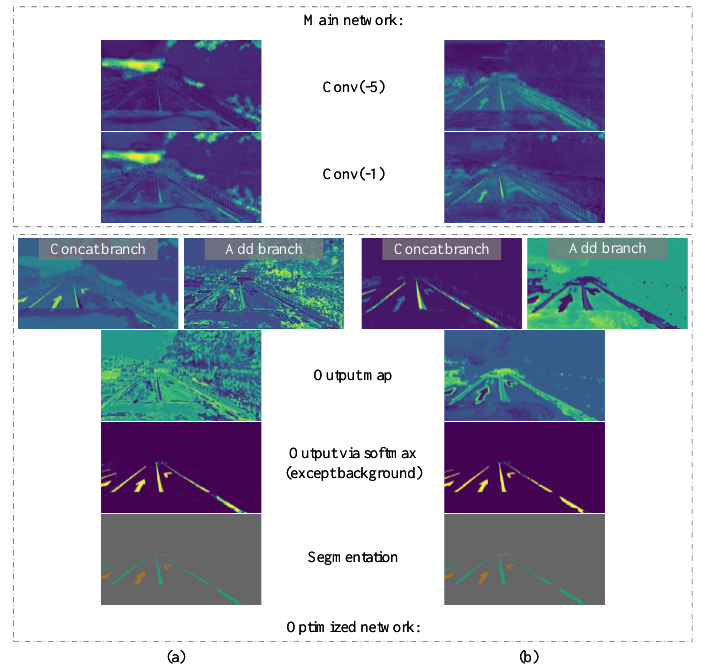
Figure 9. Output and intermediate feature maps of our model under two training strategies. ( a ) The model with direct joint training from start to finish. The main network cannot focus on the lane and road marker targets, and the optimized network produces a large amount of noise. ( b ) The model in which the main network is trained first and then they are trained together. The main network can extract the target features correctly, and the optimized network produces only a small amount of noise, and the model output is